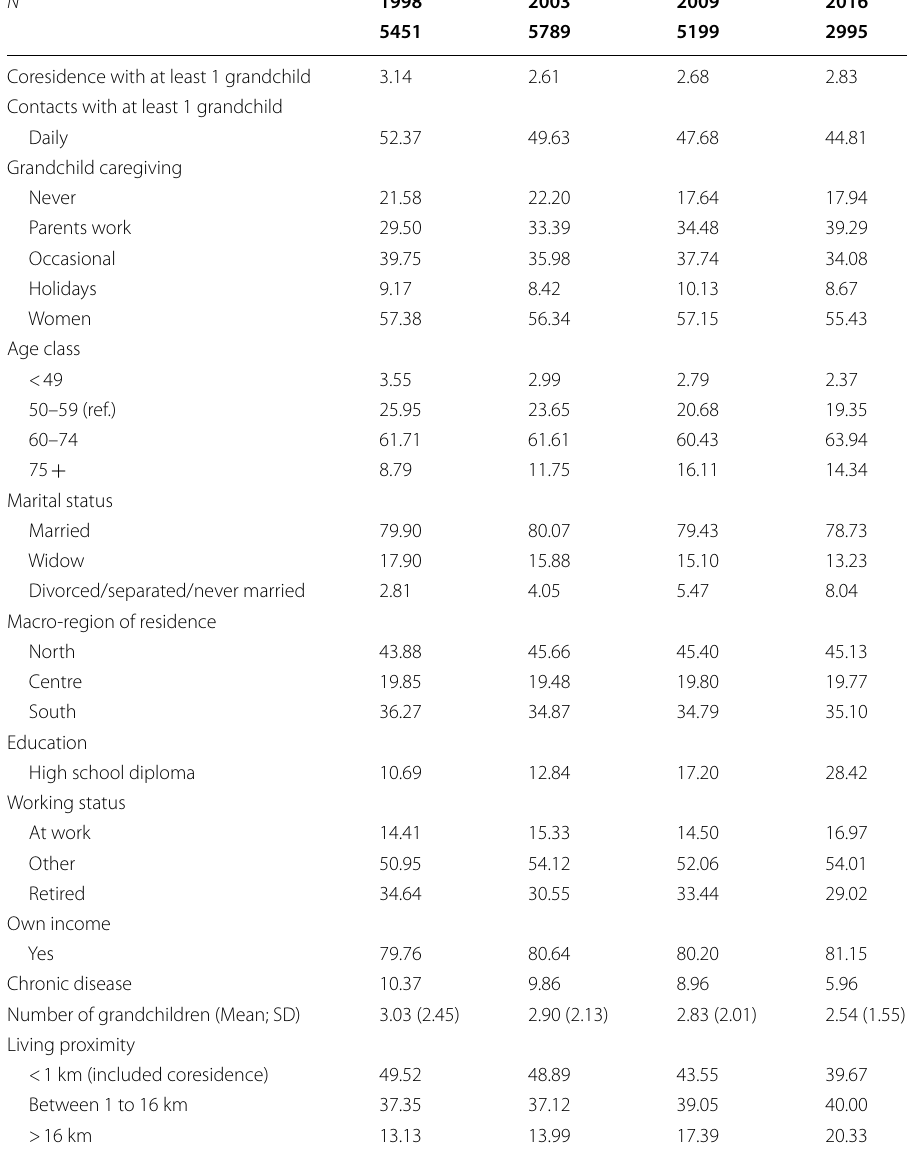
Table 6 Weighted descriptive characteristics of respondents with grandchildren younger than 13 years by